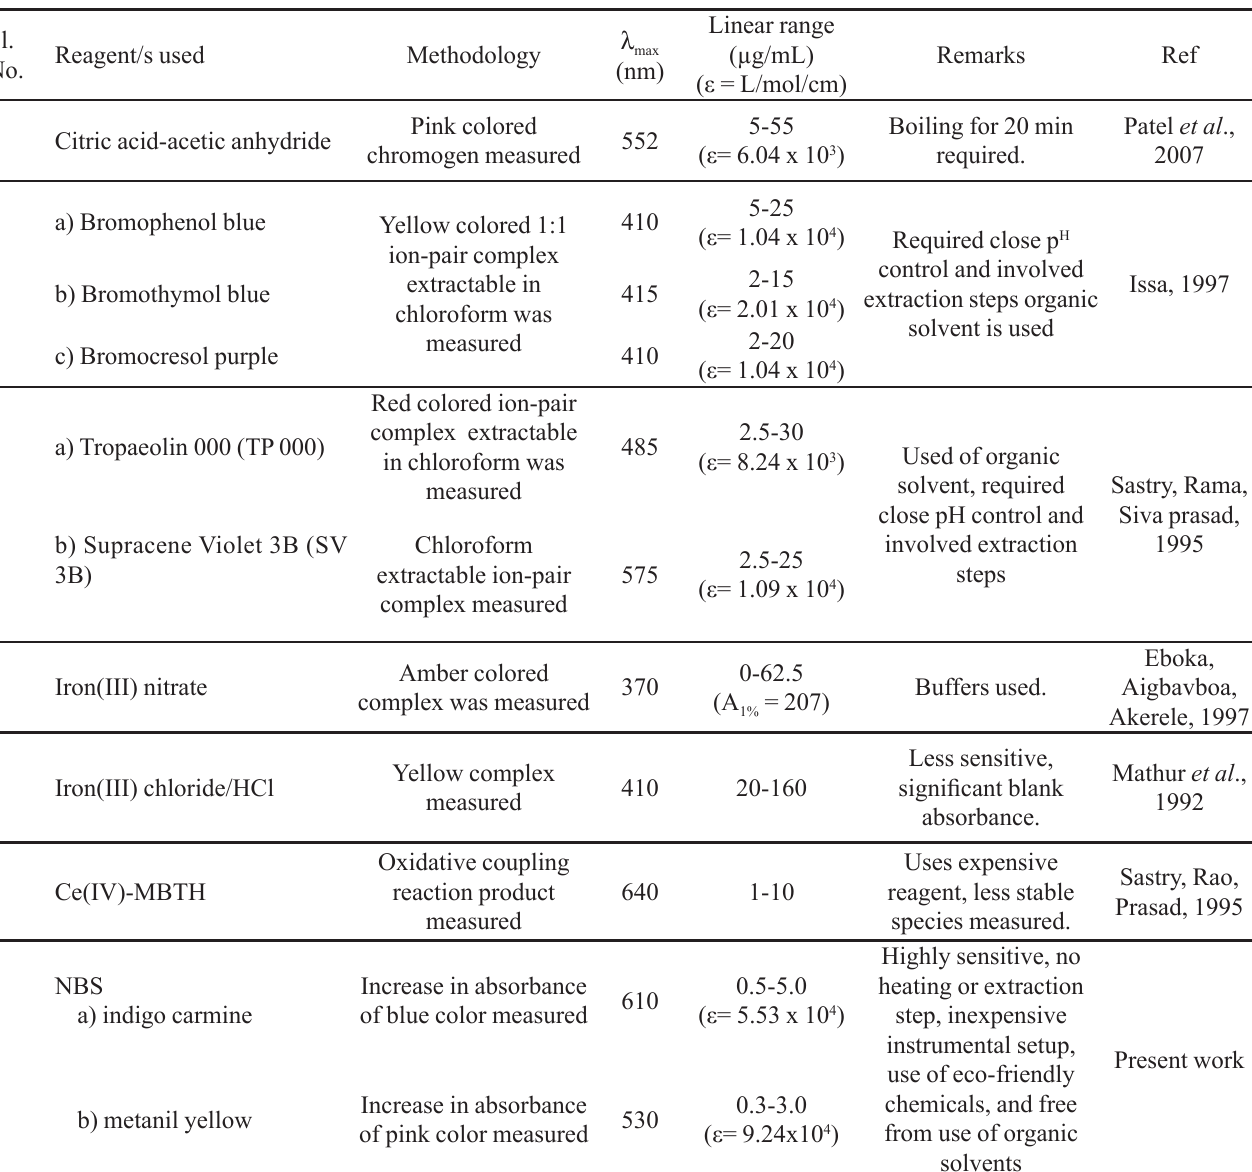
TABLE I - Comparison of performance characteristics of present methods with published methods